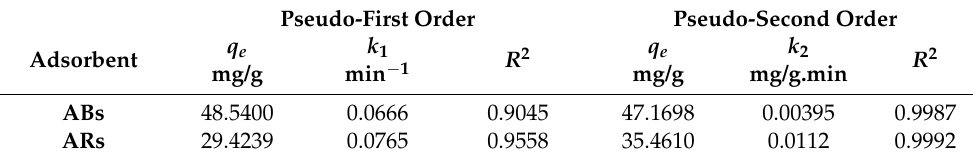
Figure 18. The pseudo-Second-order kinetics model for adsorption of oil onto adsorbents: ( a ) ABs and ( b ) AR adsorbent (1g adsorbents, pH 6.5, Temp. 25 ◦ C). Table 6. The parameter of kinetic models and correlation